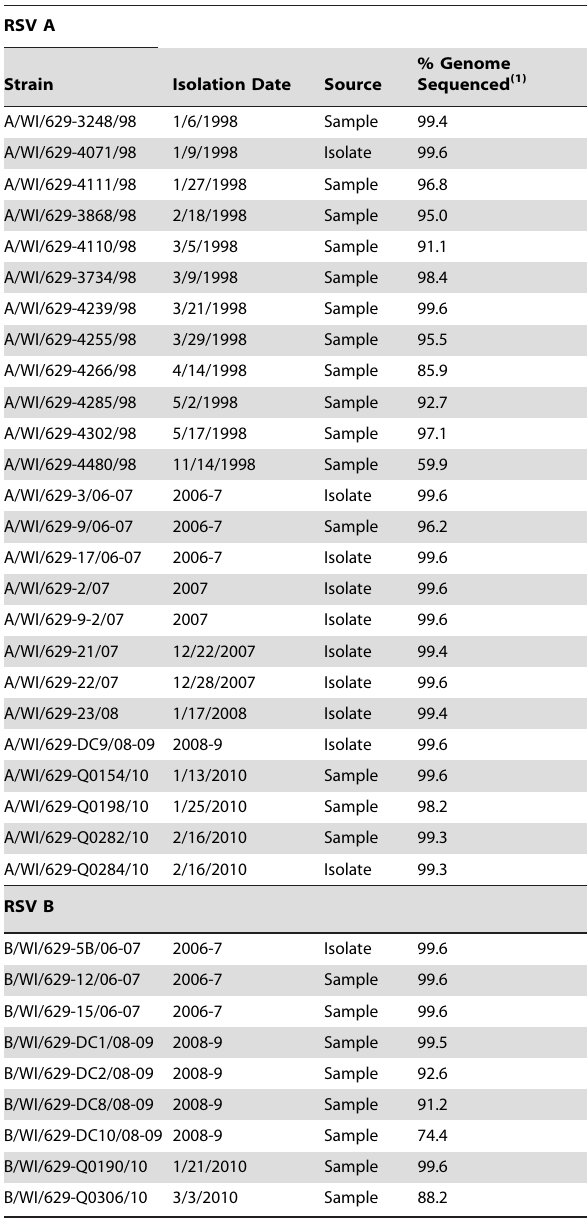
(1) The percent of the genome sequenced for each of the isolate/sample was calculated as the length (nt) of each isolate/sample sequenced divided by the total length (nt) of the prototype strain published for RSV. Previous to this calculation the sequences of the isolates/samples for RSV group A and group B were aligned to the prototype strains for RSV group A (M74568) and group B (AF013254)